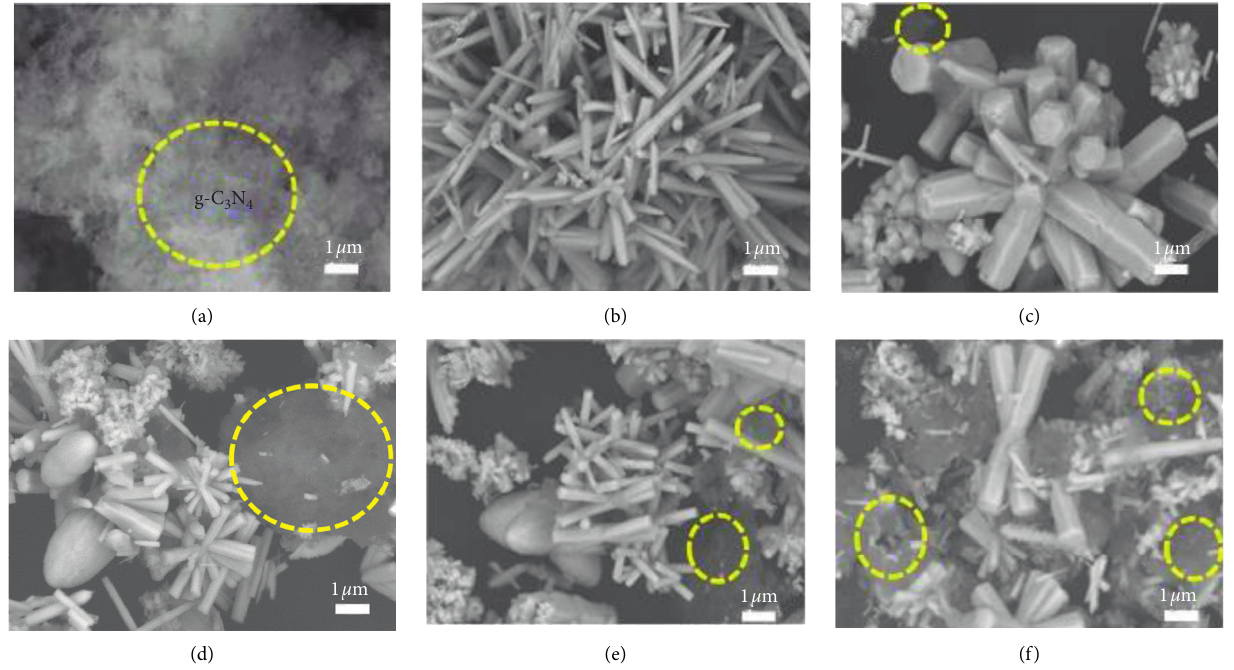
Figure 2: SEM images of (a) g-C 3 N 4 , (b) ZnO, (c) Z-1C, (d) Z-3C, (e) Z-5C, and (f) Z-7C.